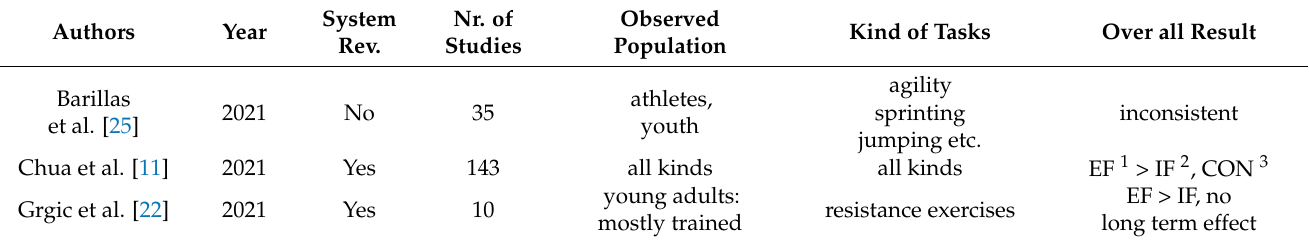
Table 1. Reviews compiling attentional focus studies since